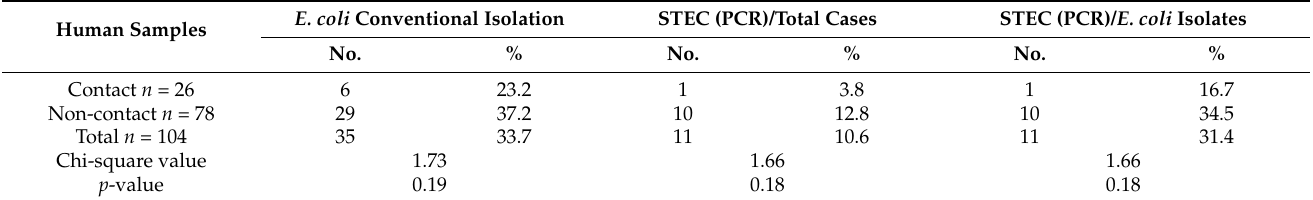
Table 4. Isolation of E. coli from human stool samples.